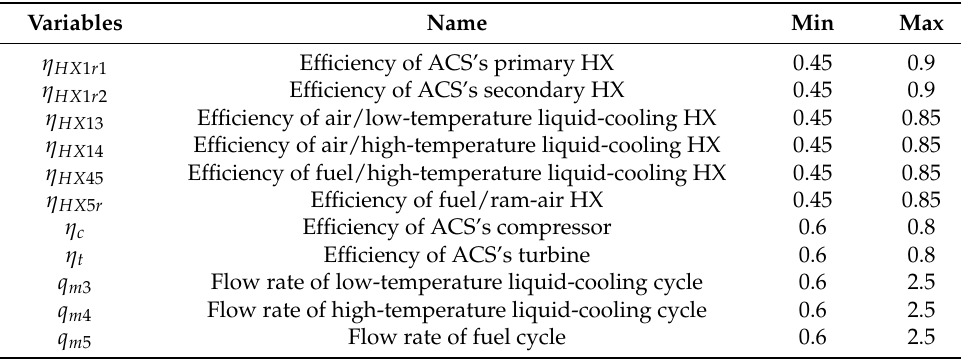
Table 3. Ranges of thermal management system optimization